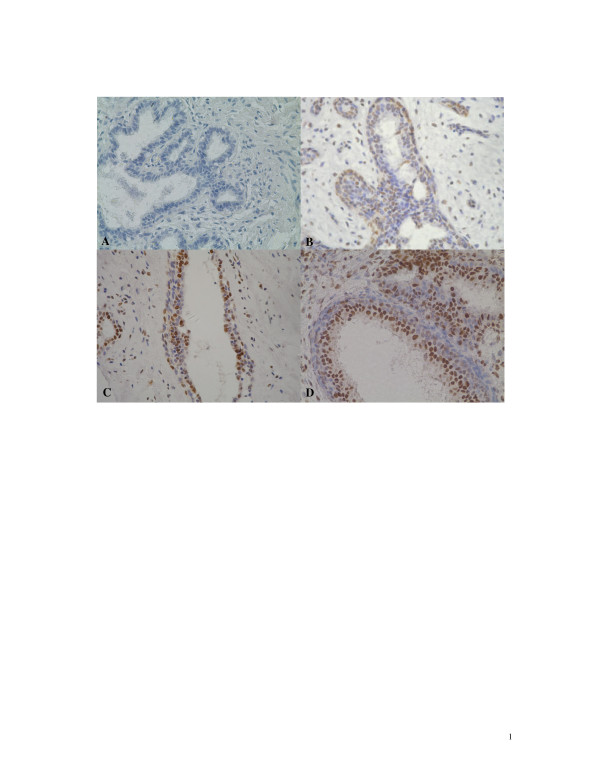
The immunohistochemical staining of Fra-1 in benign breast tumors. Paraffin-embedded tissue sections were prepared. Endogenous peroxidase activity was quenched using 3% hydrogen peroxide before immunohistochemical staining. The Streptavidin-Biotin method was used to detect Fra-1 expression. The rabbit anti-human Fra-1 polyclonal antibody at a concentration of 5 μg/ml in PBS was applied for 60 minutes at 37°C or overnight at 4°C. The sections were then incubated with biotinylated anti-rabbit antibody at 37°C for 15 minutes. The streptavidin peroxidase reagent was applied at 37°C for 15 minutes. The color was developed by incubating with DAB solution. A, nonspecific immunoglobulin was used as a negative control. B, The nuclear immunoreactivity for Fra-1 was identified mostly in the epithelial cells of fibroadenomas. C, The strong nuclear immunostaining was present in fibroadenomas. D, Positive staining appeared largely on the apical epithelial layer on the luminal aspect, but myoepithelial layer was mostly negative. ×400 magnification.